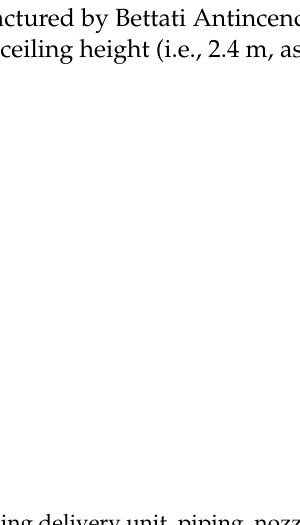
Figure 5. Discharge system, including delivery unit, piping, nozzles, and detection set.